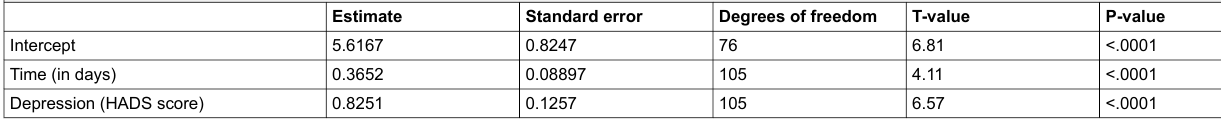
Table 4: Results of the random-intercept regression model with number of symptoms as outcome variable.